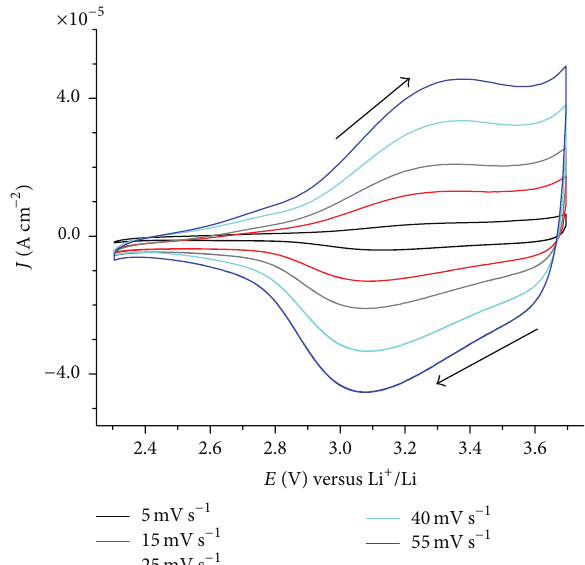
Figure 19: Scan rate dependence of the cyclic voltammograms of spray-deposited onto ITO. All voltammo- ERY-sensitized CS NiO x grams have been recorded in dark conditions within the potential oxidation (Figures 6 and 9). Scan rates were range of bare CS NiO x varied between 5 and 55 mVs −1 . Counter electrode: Li; reference redox couple: Li + /Li. Electrolyte composition as in Figure 1. Arrows indicate the verse of potential scan. Prior to sensitization the coating was 0.3 𝜇 m. thickness of the CS NiO x